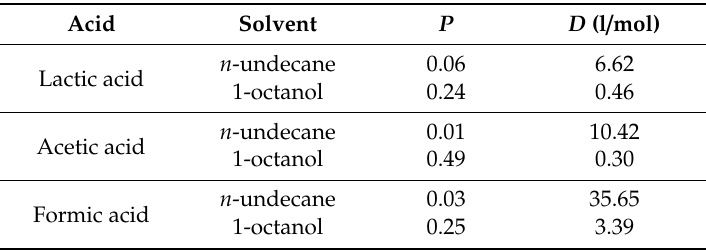
Table 1. Summary of the calculated partitioning coe ffi cient and dimerization factor for lactic acid, acetic acid and formic acid using n -undecane and 1-octanol; c acid,initial = 0.2–1.0 mol / L; T = 25 ◦ C; ambient